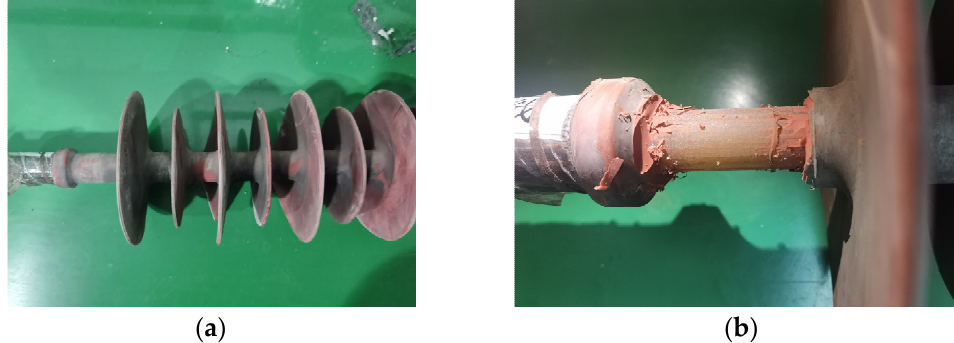
Figure 6. #2’s appearance and its mandrel. ( a ) #2’s appearance; ( b ) without the skirts.